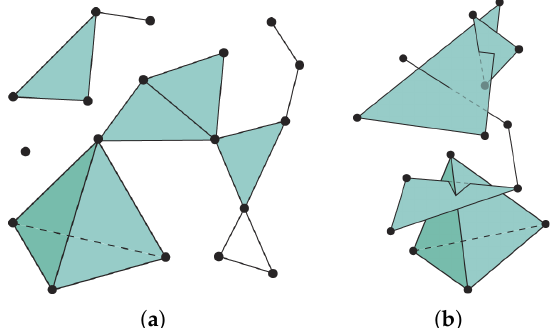
Figure 2. ( a ) A valid (geometric) simplicial complex. ( b ) A non-valid (geometric) simplicial complex. On the left we can see a valid geometric simplicial complex of dimension three (image from [8]), on the right we can see a non-valid geometric simplicial complex (image from [9]) because the second condition of the Definition 2 is not